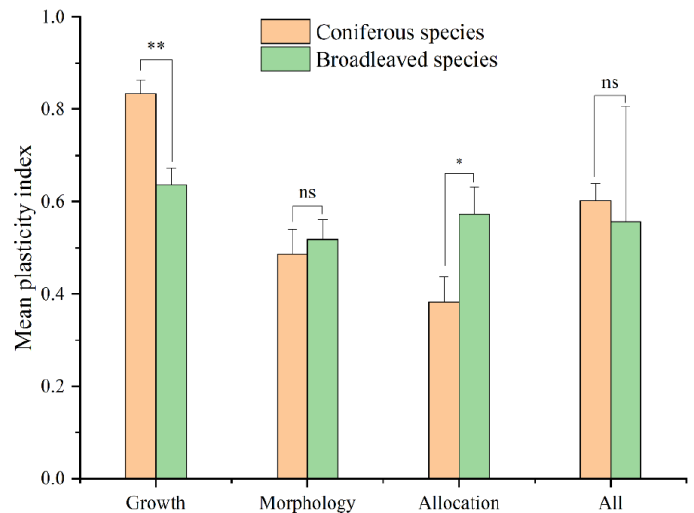
Figure 2. Mean phenotypic plasticity indices of growth, morphology, biomass allocation, and all variables combined for five species. * p < 0.05, ** p < 0.01, ns = not